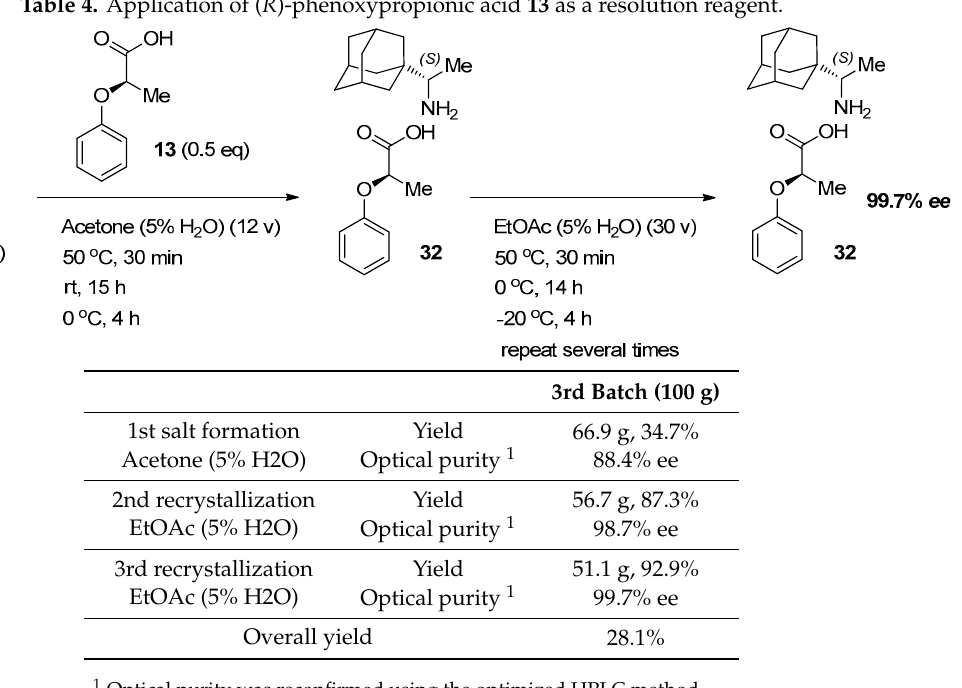
Molecules 2019 , 24 , x Table 4. Application of ( R )-phenoxypropionic acid 13 as a resolution Table 4. Application of ( R )-phenoxypropionic acid 13 as a resolution reagent.